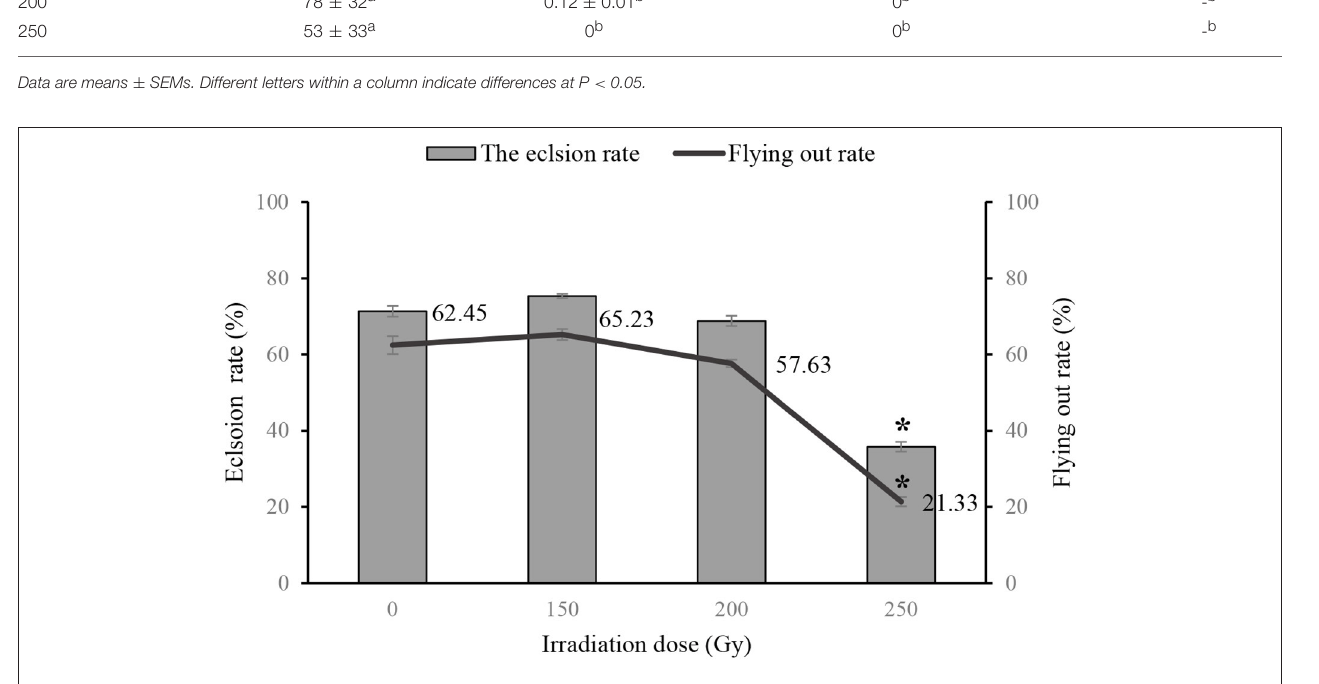
Frontiers in Physiology |